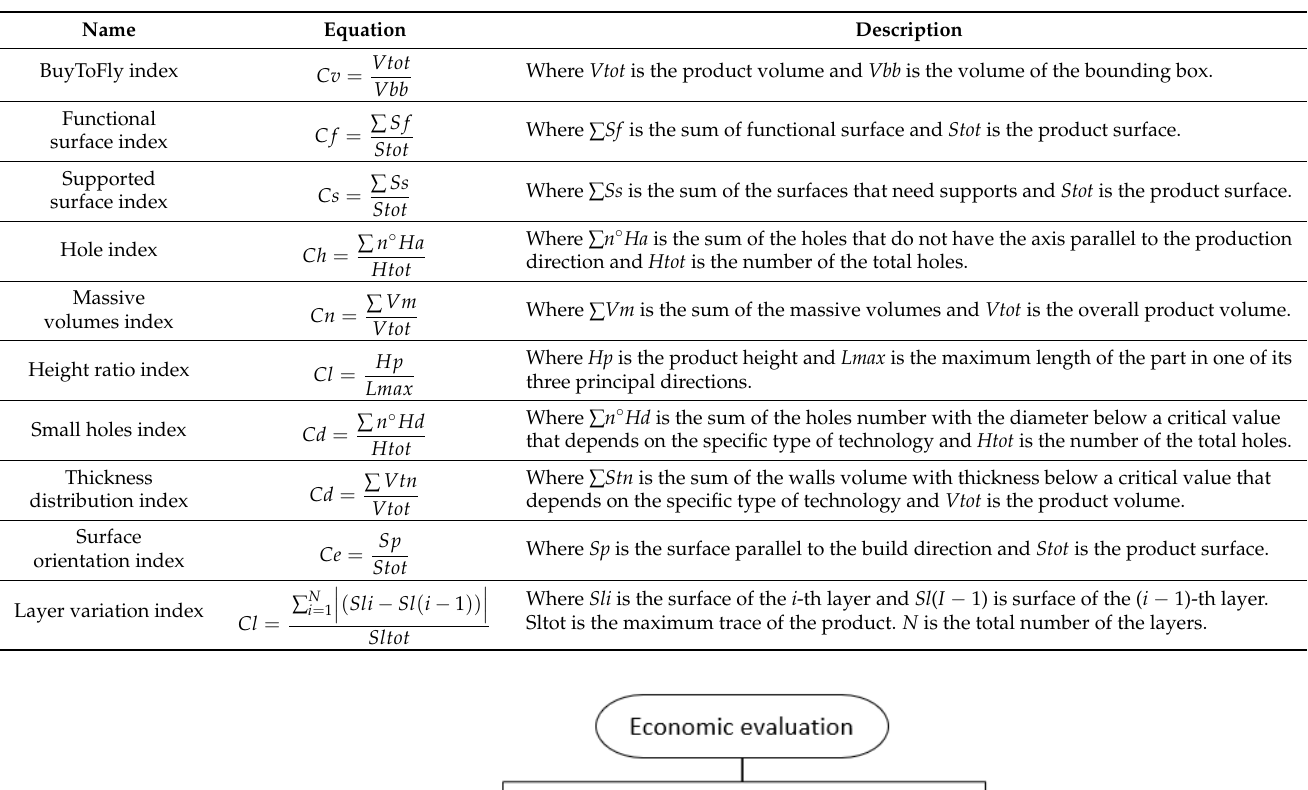
Table 6. Indices contributing to the Printability Index.